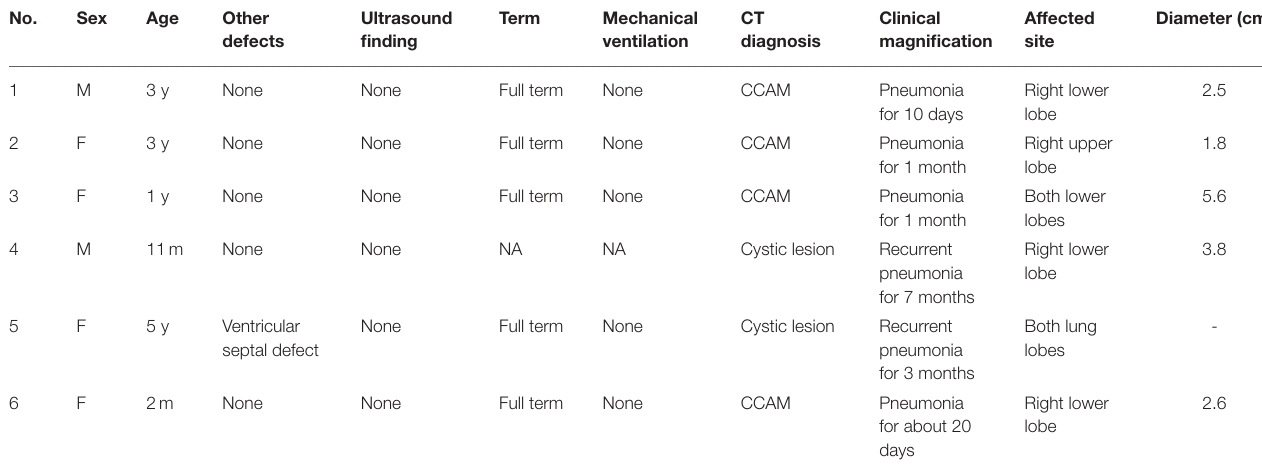
TABLE 1 | Clinical features of the six cases with PPIE. No.